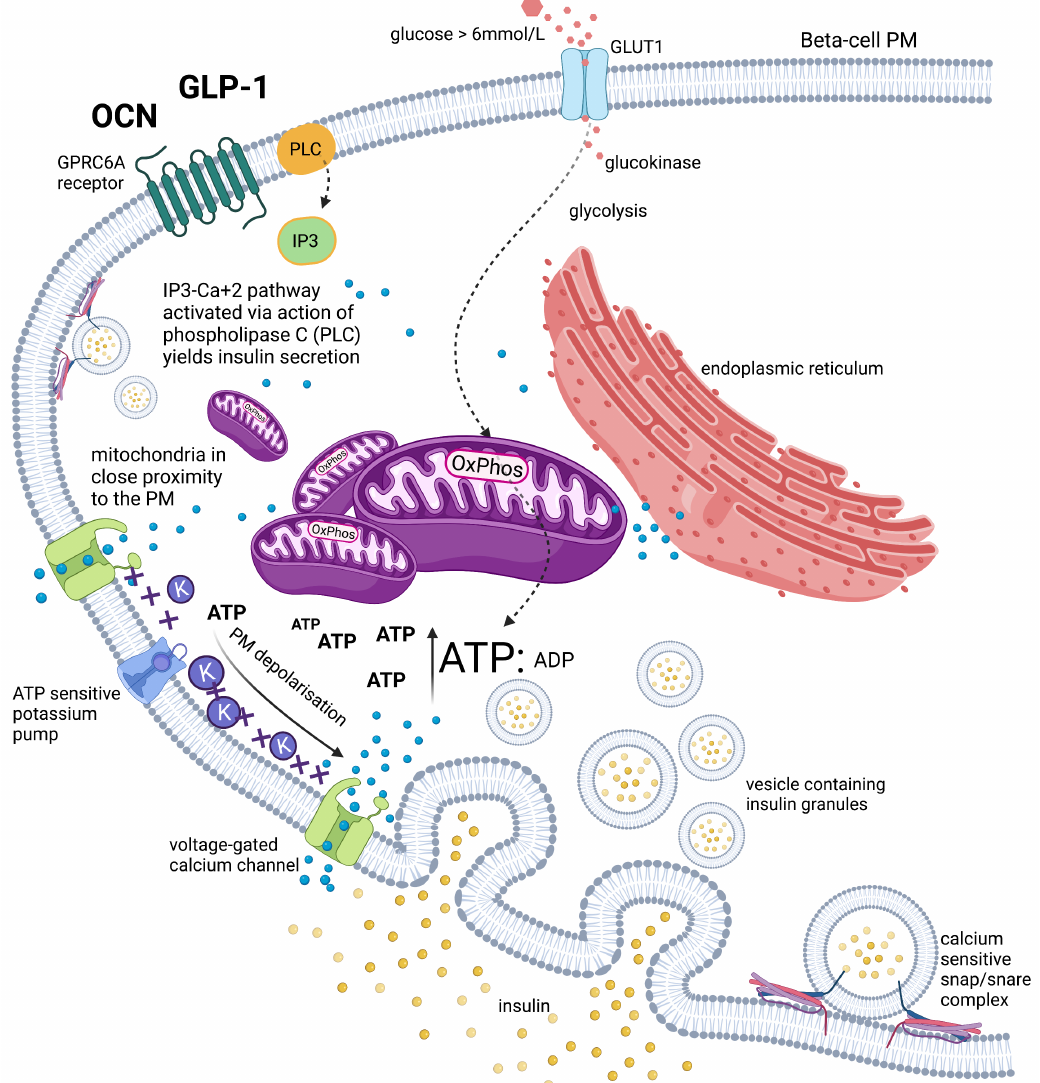
Figure 1. Schematic representation of beta-cell intracellular mechanisms involved in insulin secretion. Adenosine diphos- phate (ADP), adenosine triphosphate (ATP), calcium (Ca 2+ ), glucagon-like peptide-1 (GLP-1), glucose transporter 1 (GLUT1), G-protein coupled receptor 6A (GPRC6A), inositol-1,4,5-trisphosphate (IP3), plasma membrane (PM), osteocalcin (OCN), oxidative phosphorylation (OxPhos), phospholipase C (PLC), potassium (K +